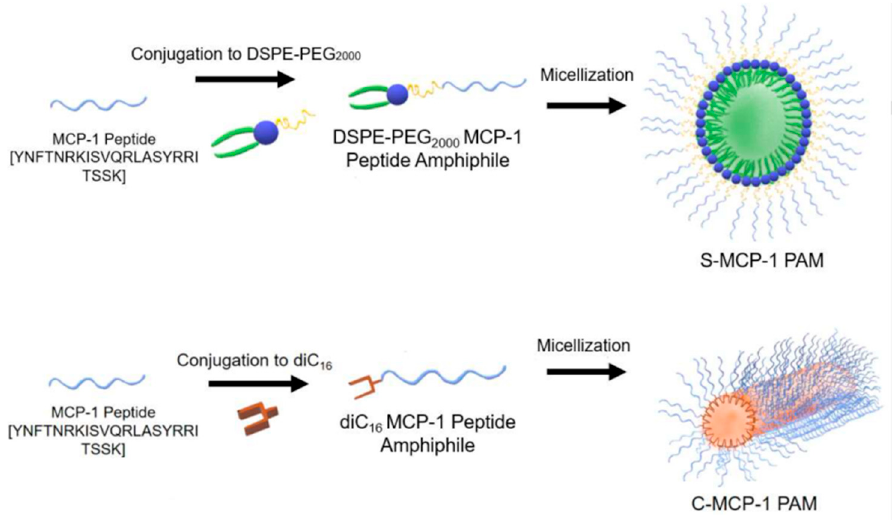
Figure 14. The monocyte chemoattractant protein-1 (MCP-1) peptide was conjugated to 1,2-distearoyl-sn-glycerol-3-phosphatidylethanolamine (DSPE)–poly(ethylene glycol) (PEG2000) to form spherical MCP-1 peptide amphiphile micelles (PAMs), or to diC16 tail to form cylindrical MCP-1 PAMs [126].